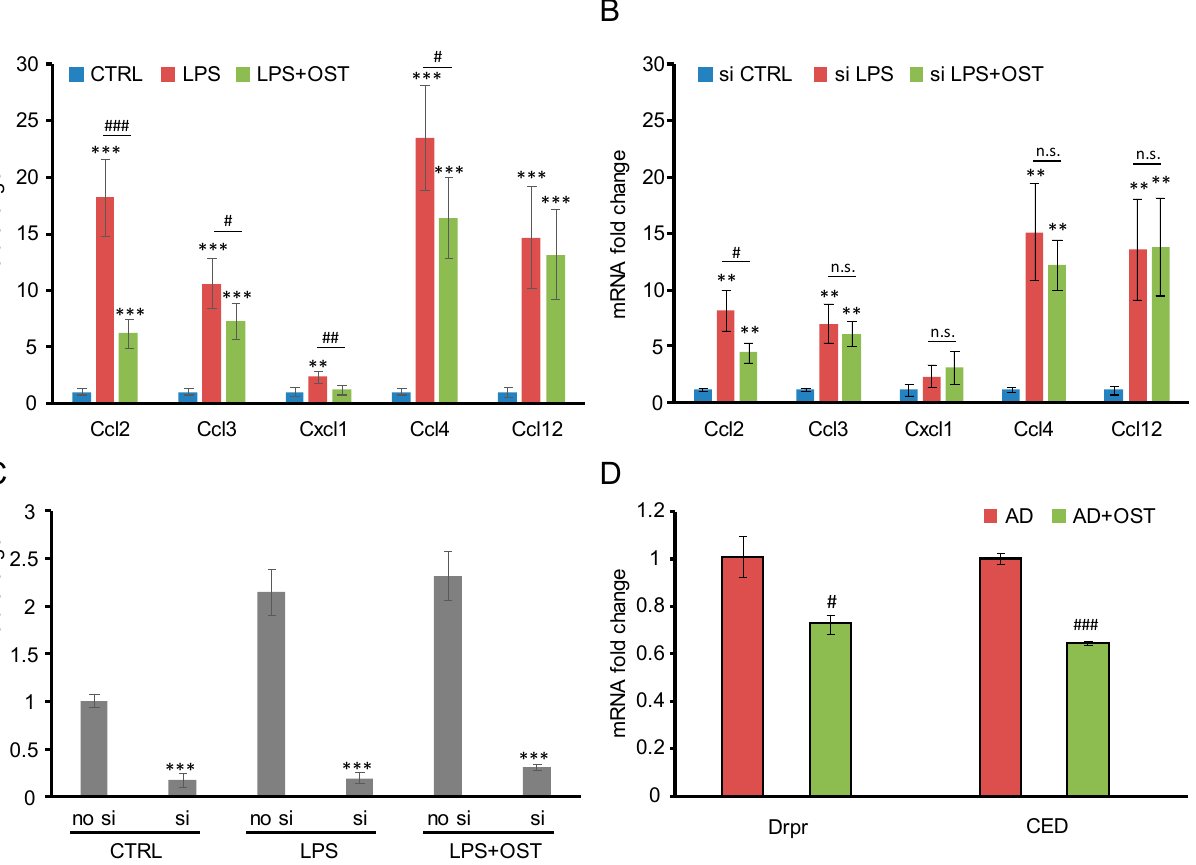
Figure 3. Nrf2 siRNA suppressed OST-induced antagonism toward microglial activation provoked by LPS. ( A ) OST antagonized LPS-induced expression of microglial activation markers in BV2 cells, while ( B ) this phenomenon was suppressed by Nrf2 siRNA. ( C ) Nrf2 siRNA effectively silenced NRF2 expression. ( D ) OST antagonized amyloid-beta (A β )-induced expression of microglial activation markers in Alzheimer’s disease model of a fruit fly. ** and *** denote p < 0.01 and 0.001 of Student’s T-test compared to CTRL group, respectively. #, ##, and ### denote p < 0.05, 0.01, and 0.001 of Student’s T-test compared to LPS-treated BV2 cells in ( A ), ( B ), or to AD flies in ( D ), respectively. The error bar stands for the standard error of the mean. n.s. stands for non-significant.